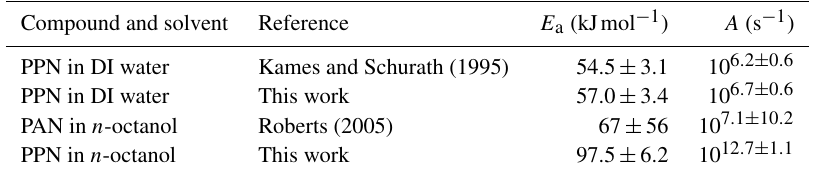
Table 5. Temperature dependence of liquid-phase loss rate